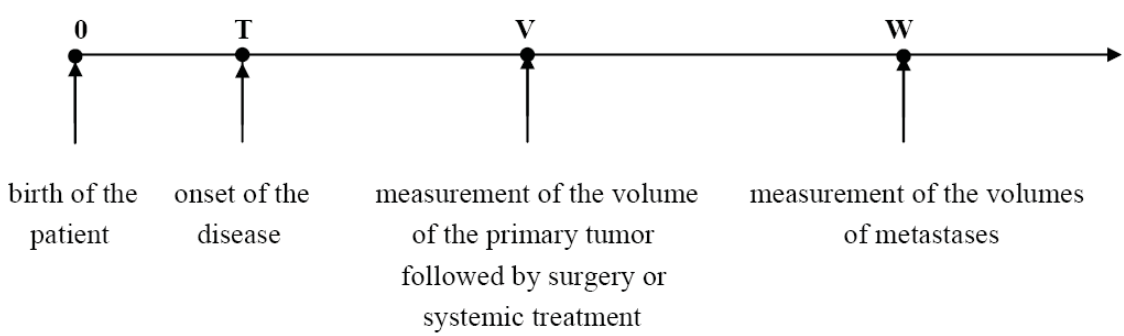
Figure 1. Timeline of the natural history and treatment of metastatic